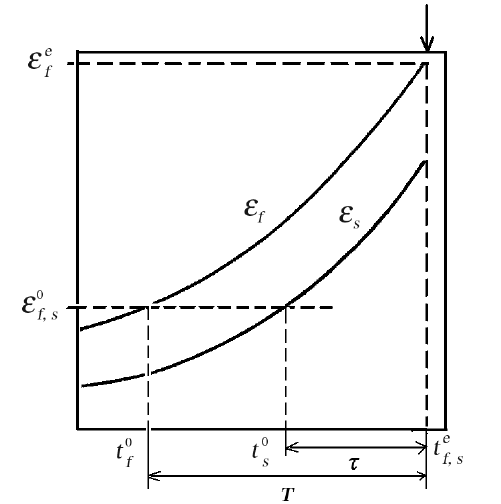
Fig. 3. Diagram illustrating the tertiary creep stage in the focal zone and at the Earth’s surface. The fol- lowing notation is used: t f e and t s e , time moments of an earthquake in the source ( f ) and at the surface ( s ); t s 0 , time moment of the anomaly appearance at the sur- face; t f 0 , reference time of inelastic deformations in the source; τ , duration of the anomalous surface signal; T, duration of the tertiary creep in the source zone; ε f 0 and ε f e , initial and final strain values in the source zone; ε s 0 , initial surface strain at which anomalies of geophysical parameters can be recorded; r f , character- istic size of the source or the radius of the focal zone; r s , hypocentral